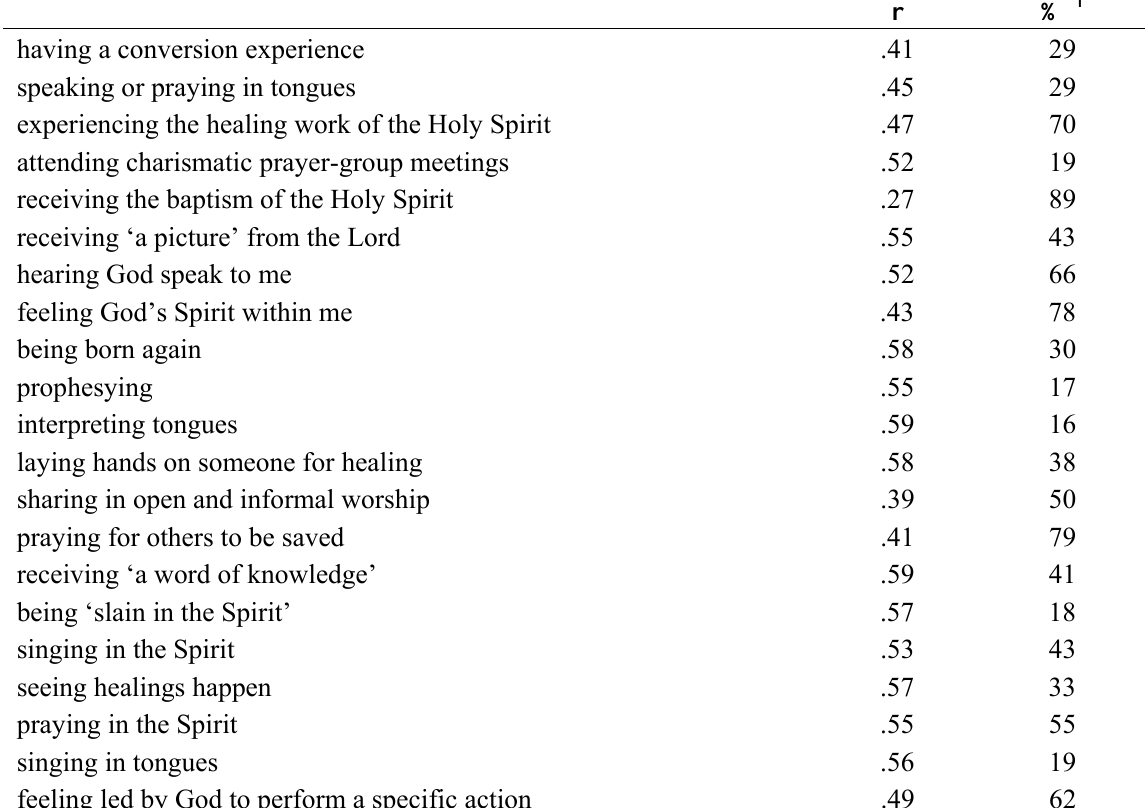
Table 1. Charismatic Orientation Scale: item rest of scale correlations and item